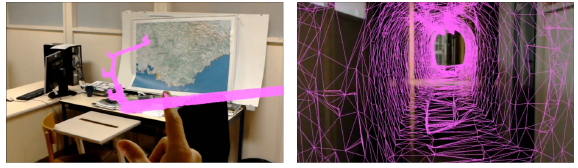
Figure 5. Visualization of digitalized sewers, at small size (left) and at 1:1 scale